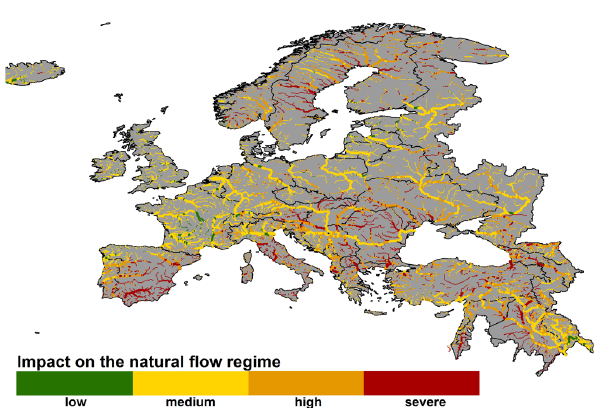
Fig. 3. Climate change impact on the natural flow regime in the 2050s under the A2 emission scenario considering 24 selected indi- cators and the ensemble mean of the three climate projections.